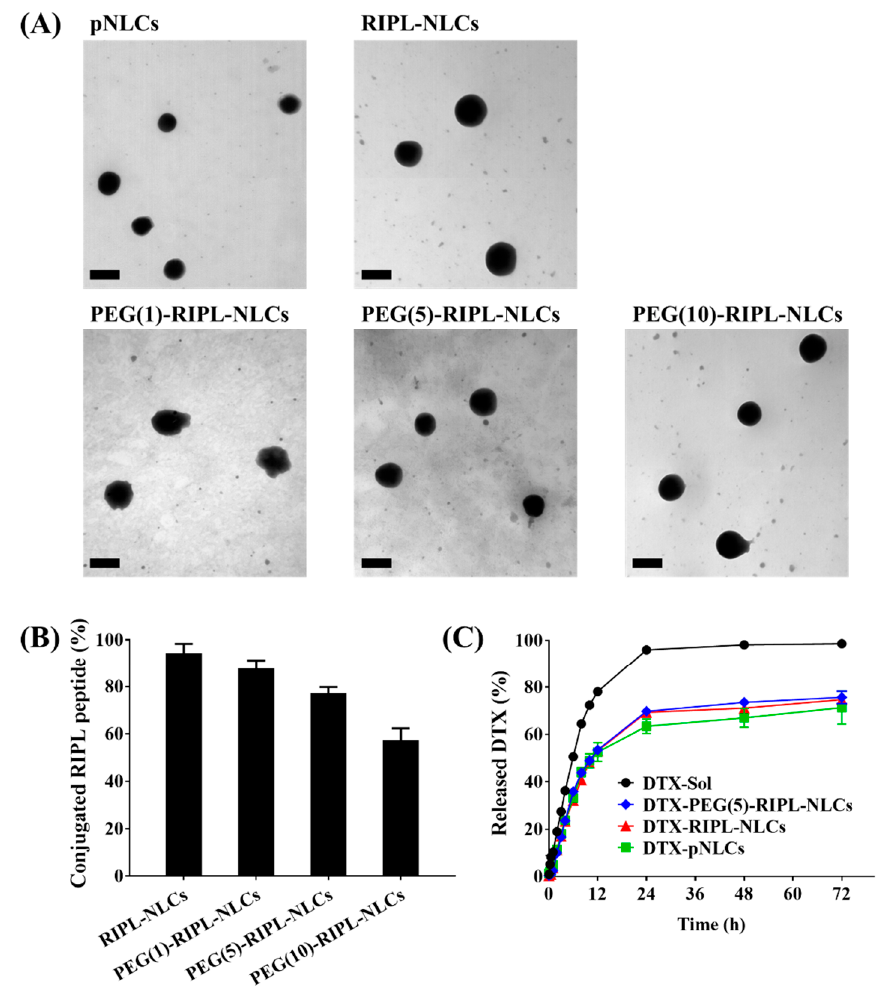
Figure 2. Characterization of various NLCs. ( A ) TEM images of docetaxel (DTX)-loaded NLCs. Scale bar = 200 nm. ( B ) Conjugation efficiencies of the RIPL peptide. Data represent the mean ± SD ( n = 3). ( C ) In vitro release profiles of DTX from various formulations. Data are the mean ± SD ( n = 3).